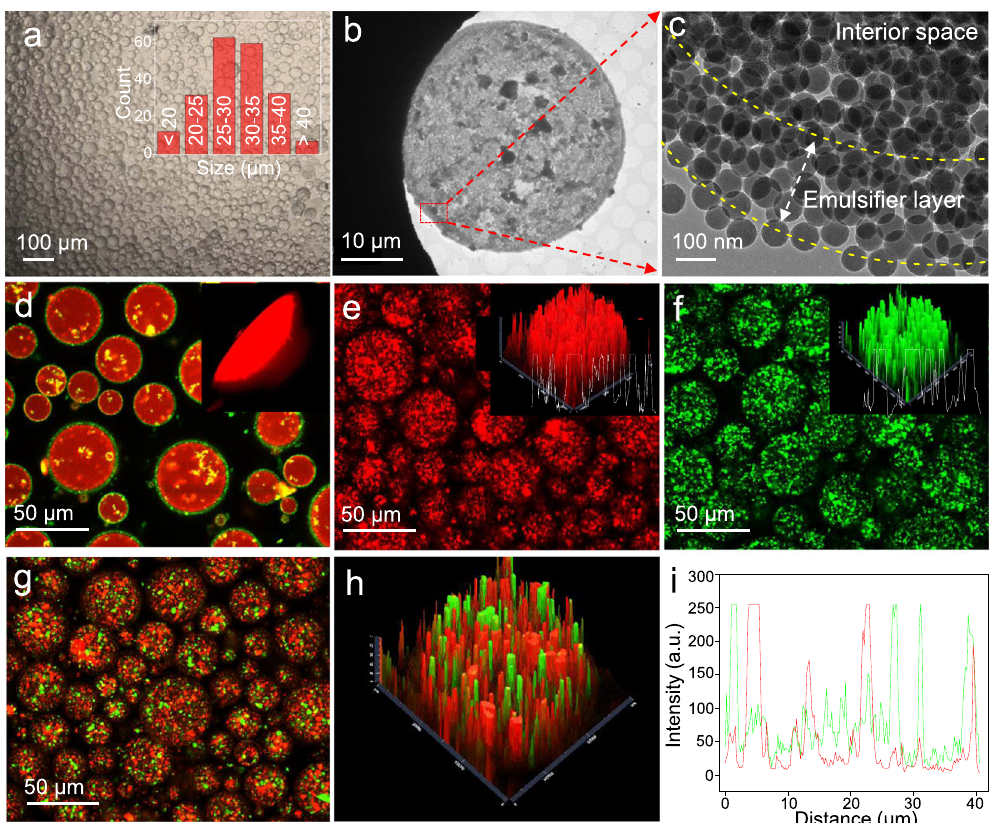
Fig. 2 Structural characterization of the biomimetic microreactors. a Optical micrograph of an IL-in-oil Pickering emulsion-based microreactor housing SCs; the inset showing the droplet size distribution. b Cryo-TEM image of a frozen SCs-containing water droplet in oil. c Magni fi ed cryo-TEM image of ( b ) showing the interface of the SCs-containing microreactor. d Confocal laser scanning microscopy image of the microreactor within which SCs were dyed with Rhodamine B and the solid particle emulsi fi er was dyed with FITC-I; inset shows its 3D image. e Confocal laser scanning microscopy image of the microreactors within which Ti/SCs were dyed with Rhodamine B (red). f Confocal laser scanning microscopy image of the microreactors within which CALB/SCs were dyed with FITC-I (green); 3D image shows the distribution of SCs within the microreactor and the fl uorescence intensity pro fi le along its diameter. g Confocal laser scanning microscopy image of the biomimetic microreactor containing FITC-I-labeled SCs and Rhodamine B-labeled SCs. h 3D confocal laser scanning microscopy image for the biomimetic microreactor in ( g ). i Fluorescence intensity pro fi les showing the distribution of the two different fl uorescently labeled